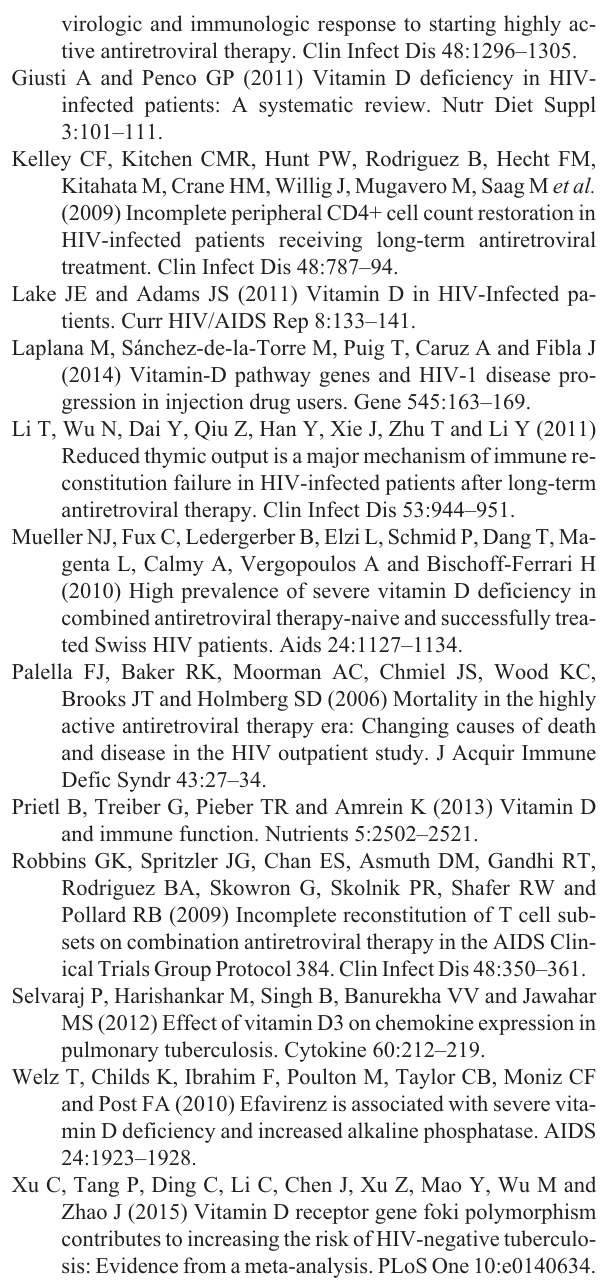
Table S1 - Allelic combination of VDR functional SNPs. Table S2 - Adjusted clinical variables logistic regression model of VDR genotypes. Table S3 - Plasma levels of 25-hydroxy vitamin